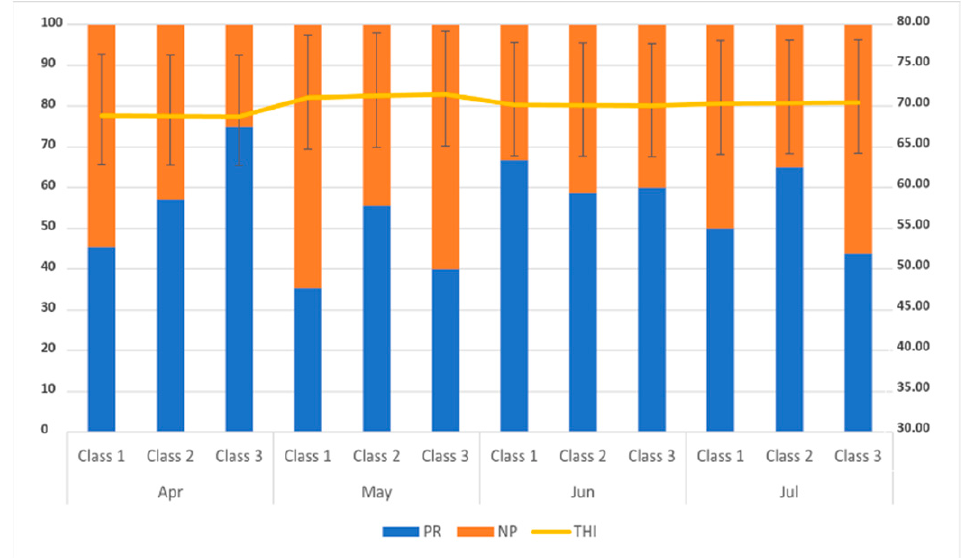
1.34 ± 0.0 Values are expressed as mean ± standard error. X,Y , values within the same column differ significantly at p < 0.01. A,B , values within each row are significantly different at p < 0.01. A further analysis was carried out to evaluate the pregnancy rate (PR) in animals treated throughout the year (Figure 3). Few differences were observed throughout the months. However, a higher ( p < 0.05) PR was recorded in buffaloes treated in June compared with those treated in July. Similarly, the PR at TAI and in the first cycle post-insemination was significantly ( p < 0.05) higher in June than in May (Figure 3).